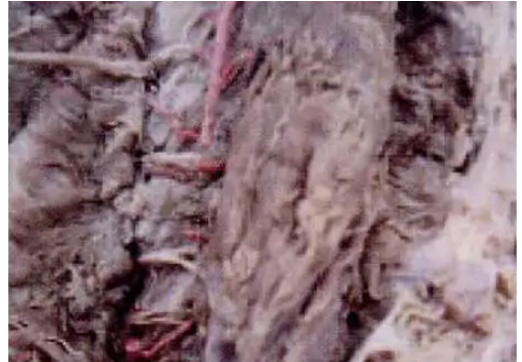
Figure 2. The results of preprocessing of anatomical images of cervical